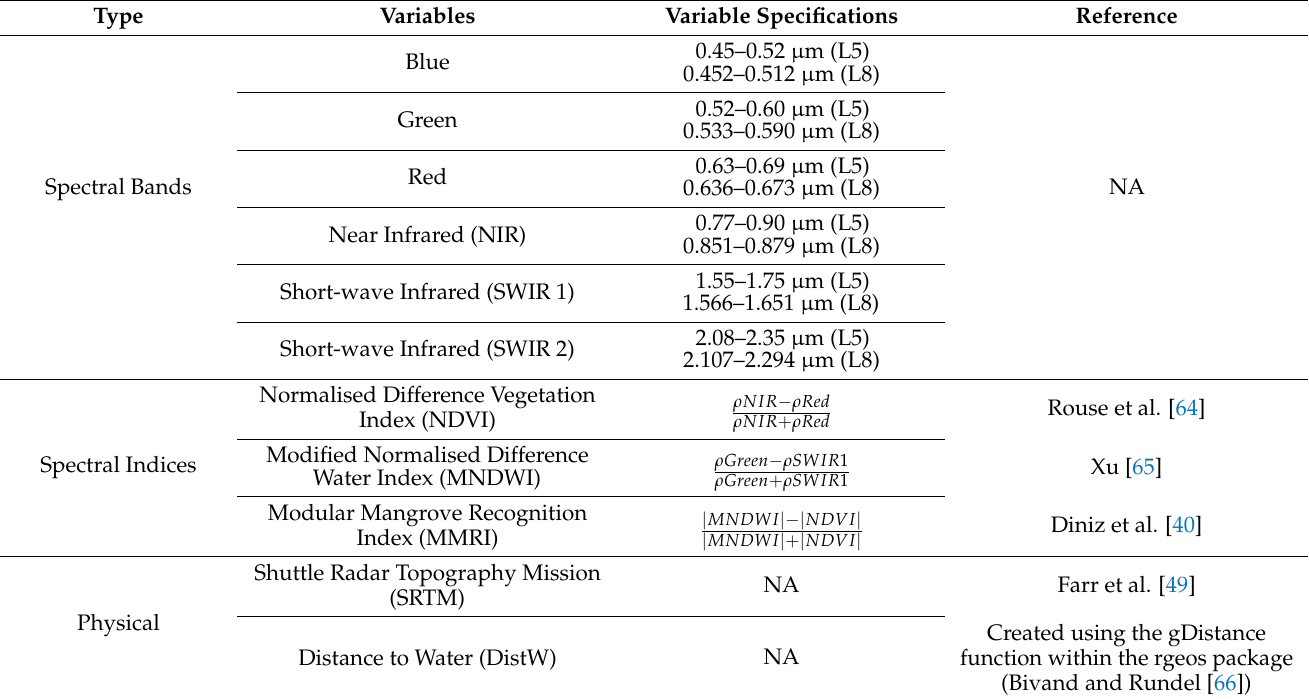
Table 1. Set of physical variables and vegetation indices used for modelling land use maps used in our study.